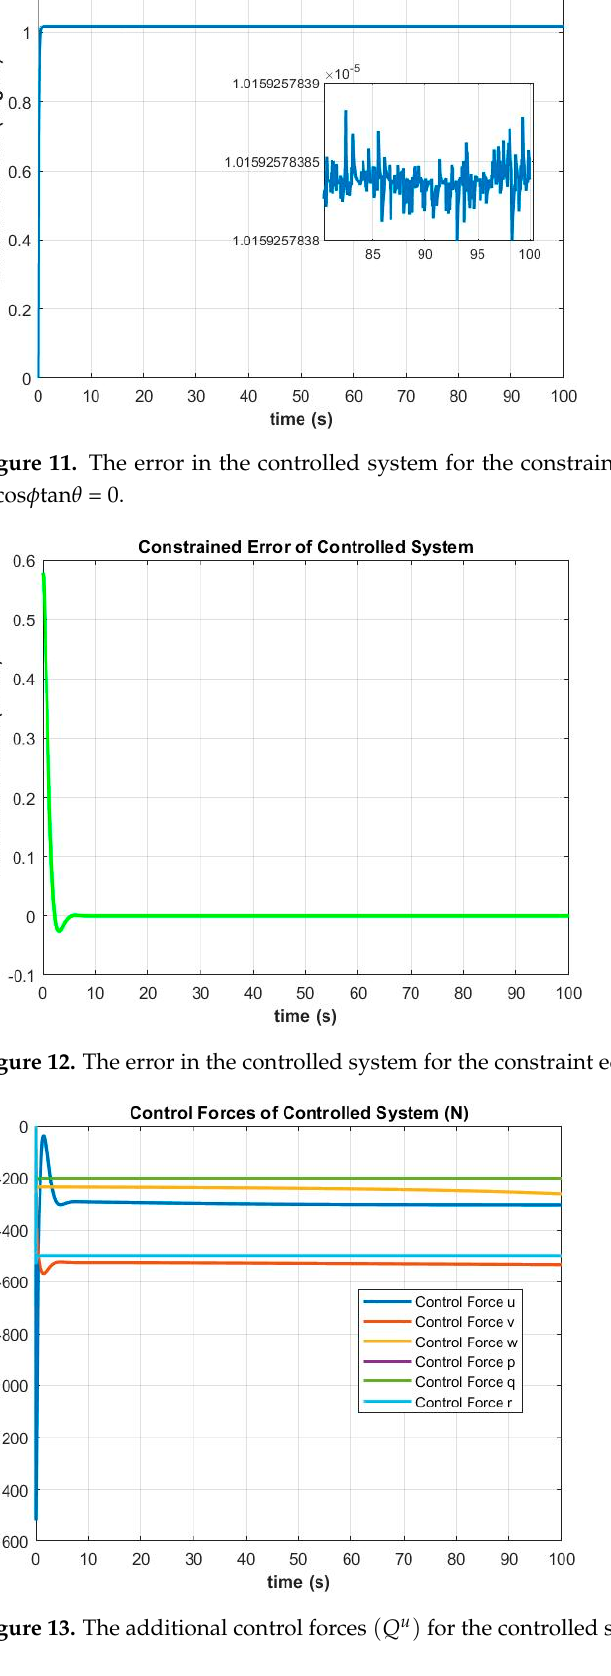
Figure 13. The additional control forces